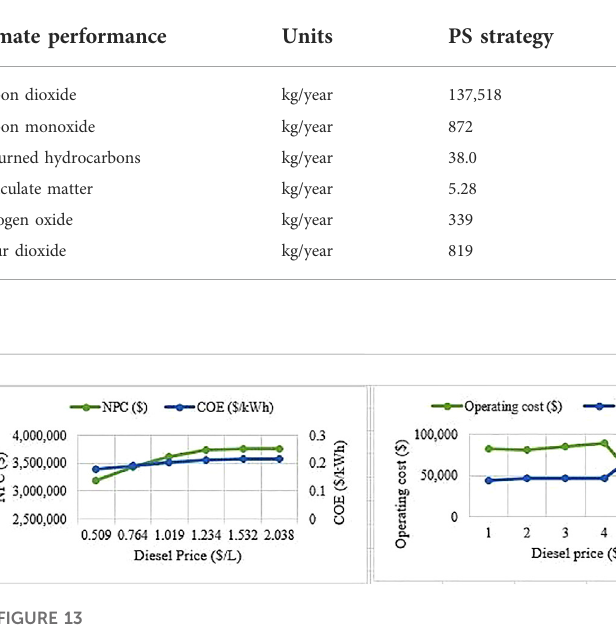
TABLE 8 Climate performance under different control strategies.